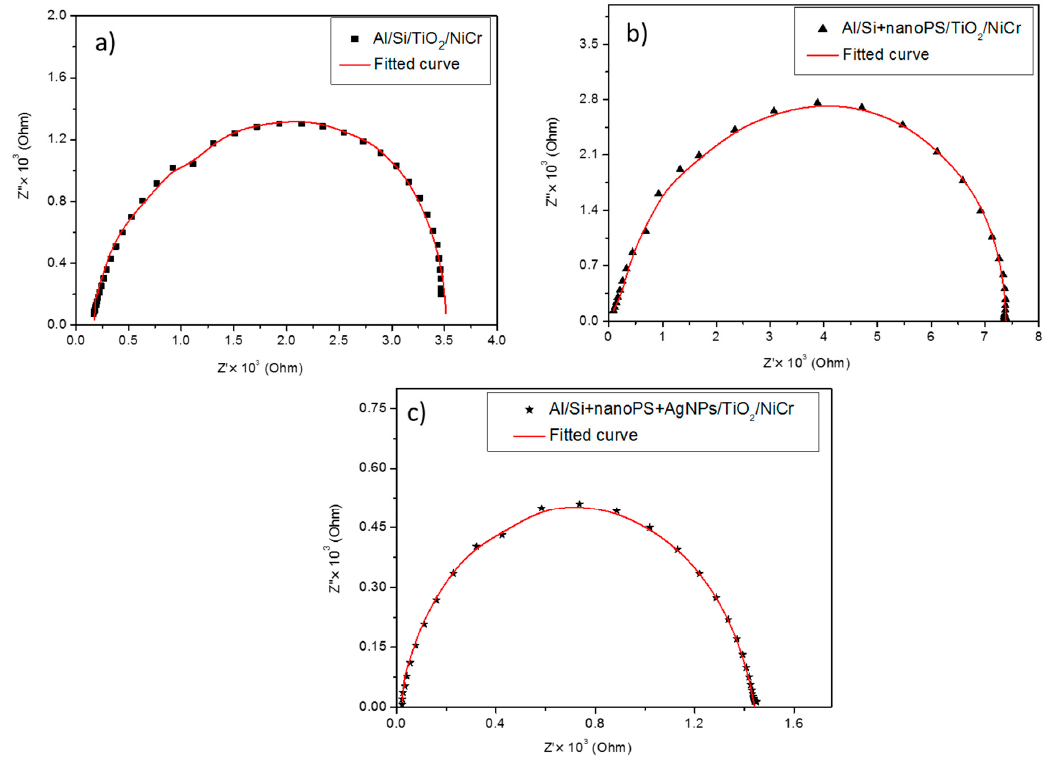
Figure 3. Nyquist diagrams and impedance fittings corresponding to ( a ) Al / Si / TiO 2 / NiCr diodes, ( b ) Al / Si + nanoPS / TiO 2 / NiCr diodes, and ( c ) Al / Si + nanoPS + AgNPs / TiO 2 / NiCr diodes.